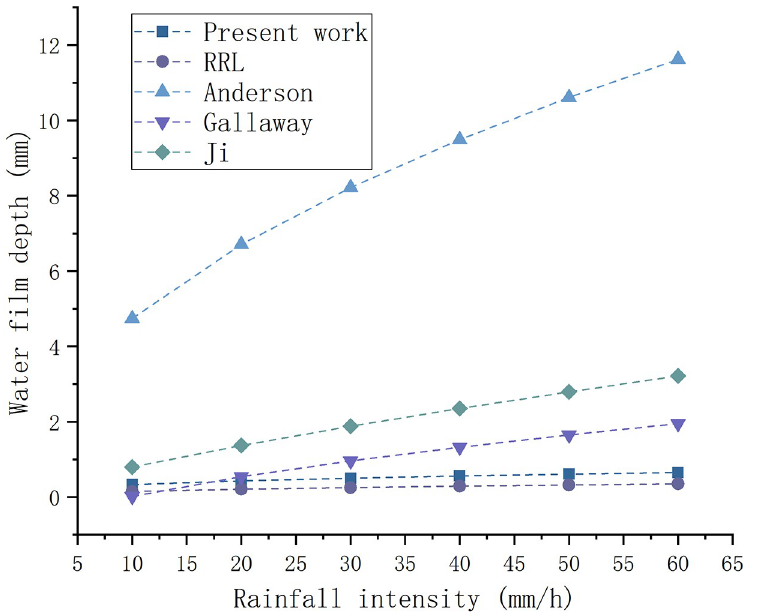
Fig 7. Comparison of prediction values among different water film depth models.